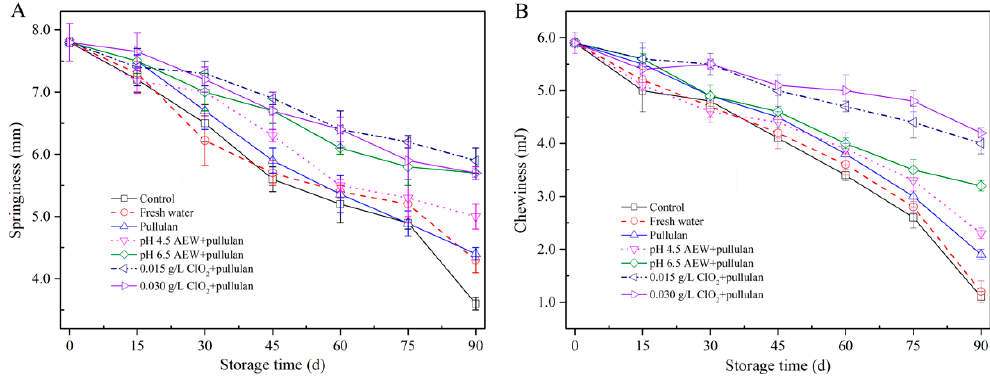
Figure 2. Texture properties of half-shell mussels treated with the control, water, and combined glazing solutions during 90 days of frozen storage. ( A ) springiness; ( B ) chewiness.